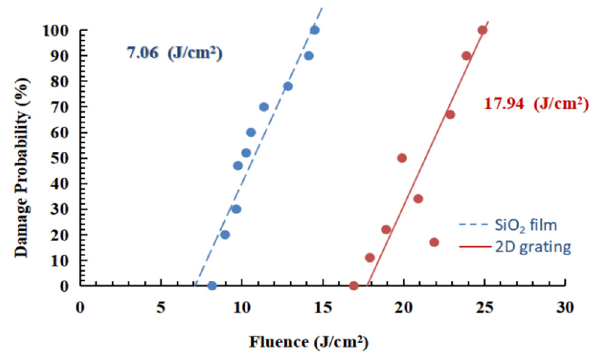
Figure 7. The LIDTs of the